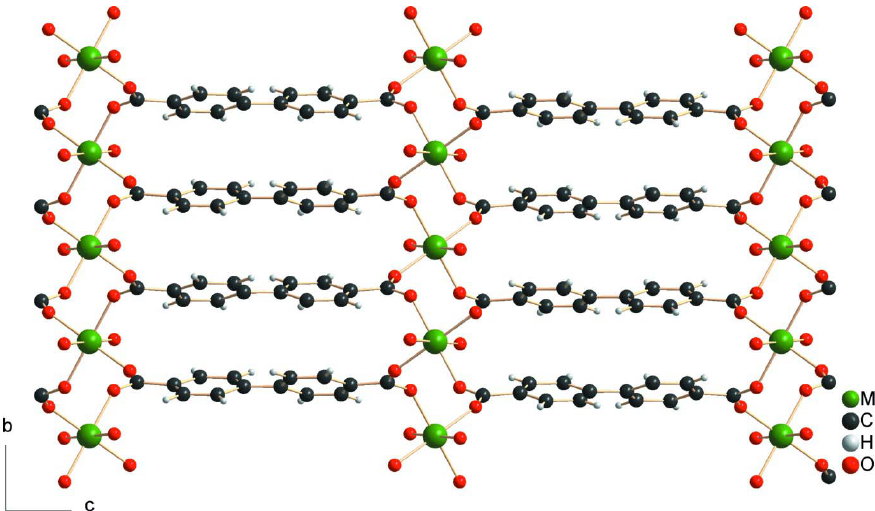
Crystal structure of the title compound with view along the a